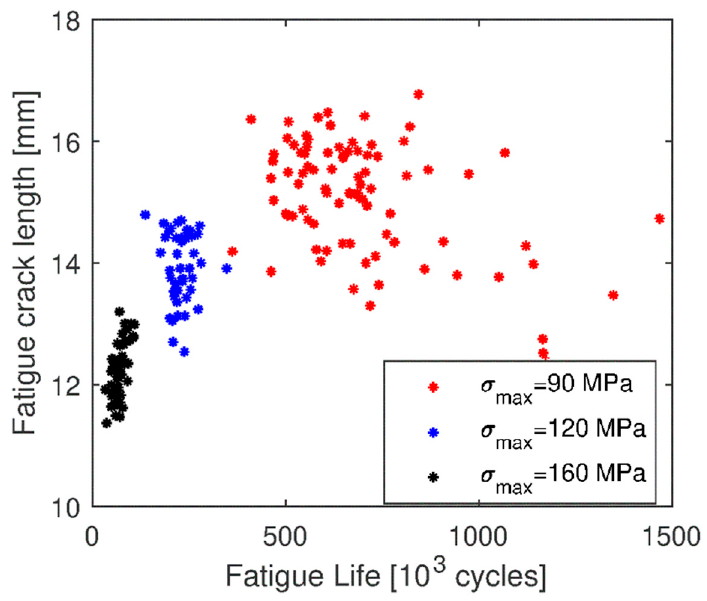
Figure 7. Critical crack size at three different levels of stress. Table 4. Average and standard deviation values for crack length.